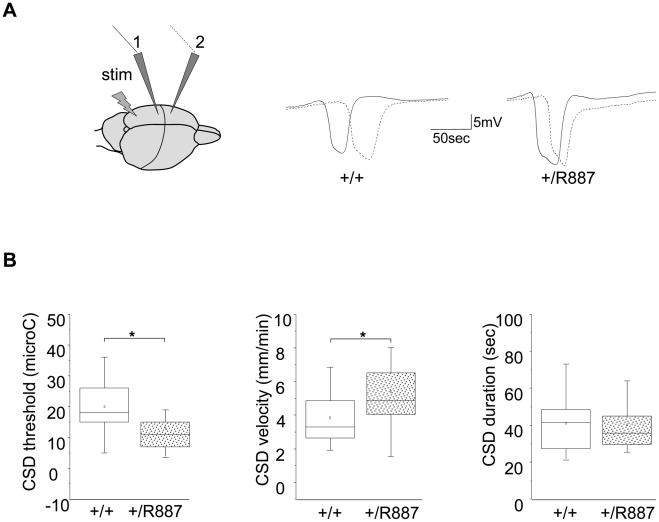
In vivo CSD recording.A. On the left, a sketch of the positioning of the stimulating (stim) and recording electrodes (1, 2) is outlined. Example of traces recorded in wild type (+/+) and Atp1a2
+/R887 mutants (+/R887) at the two electrodes with dotted line indicating the wave recorded at the first electrode and full line indicating the wave recorded at the second electrode in both wild type and mutated animals. B. CSD threshold, velocity and duration of wild type and mutant are reported in box plots reporting bottom-up the 5th percentile, 25th percentile, median, 75th percentile and 95th percentile. The single dot represents the mean value described for each group. Atp1a2
+/R887 heterozygous animals are more sensitive to CSD induction (+/R887, 13.00±1.7 µC, n = 20; +/+, 19.9±1.9 µC, n = 18; p<0.01; left graph). CSD velocity of propagation is increased in Atp1a2
+/R887 mutants (wild type, 3.85±0.35 mm/min n = 18); mutant, 5.41±0.41 mm/min, n = 20; p<0.01; middle graph). No significant difference was observed in CSD duration (wild type 41.1±3.5 sec, n = 18; Atp1a2
+/R887 40.1±3.19 sec, n = 20; p = 0.83; right graph).